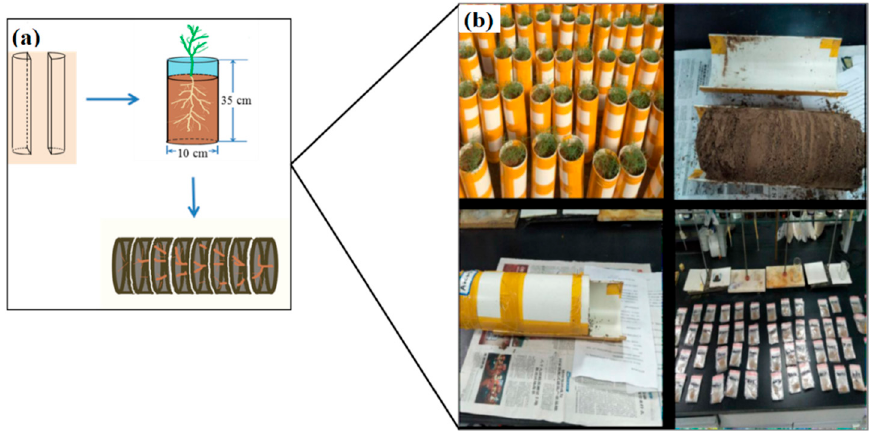
Figure 7. Experimental device and root samples. ( a ) Experimental setup. ( b ) Experimental procedure from seeding to root collection.